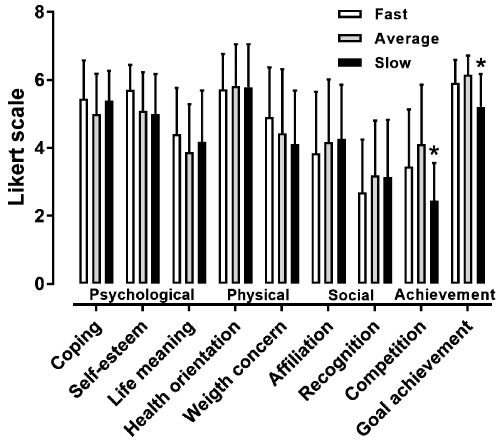
Figure 4. The nine MOMS specific themes by performance group in female participants. * p < 0.05. It should be noted that the Likert scale ranges from 1 to 7.